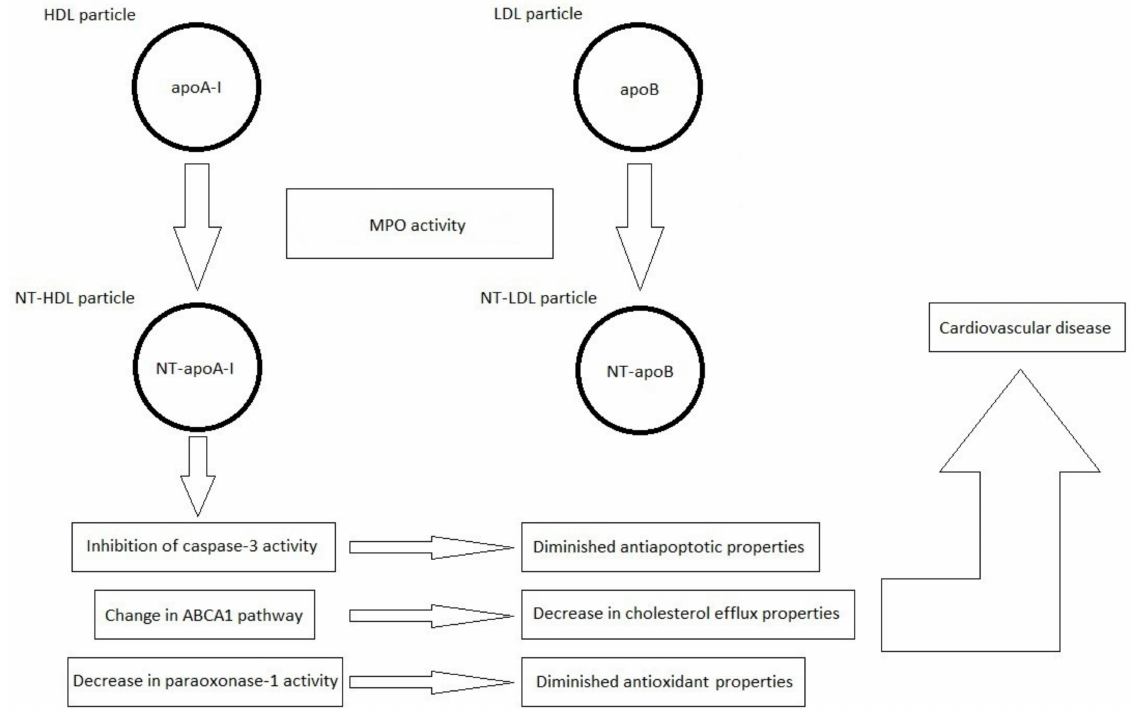
Figure 2. Formation of nitrated lipoproteins (NT-HDL and NT-LDL) under the influence of myeloper- oxidase (MPO) activity. Nitrated lipoproteins are characterized by the presence of 3-NT-Tyr in the polypeptide chains of apolipoprotein A-I (apoA-I) and apolipoprotein B (apoB), respectively,